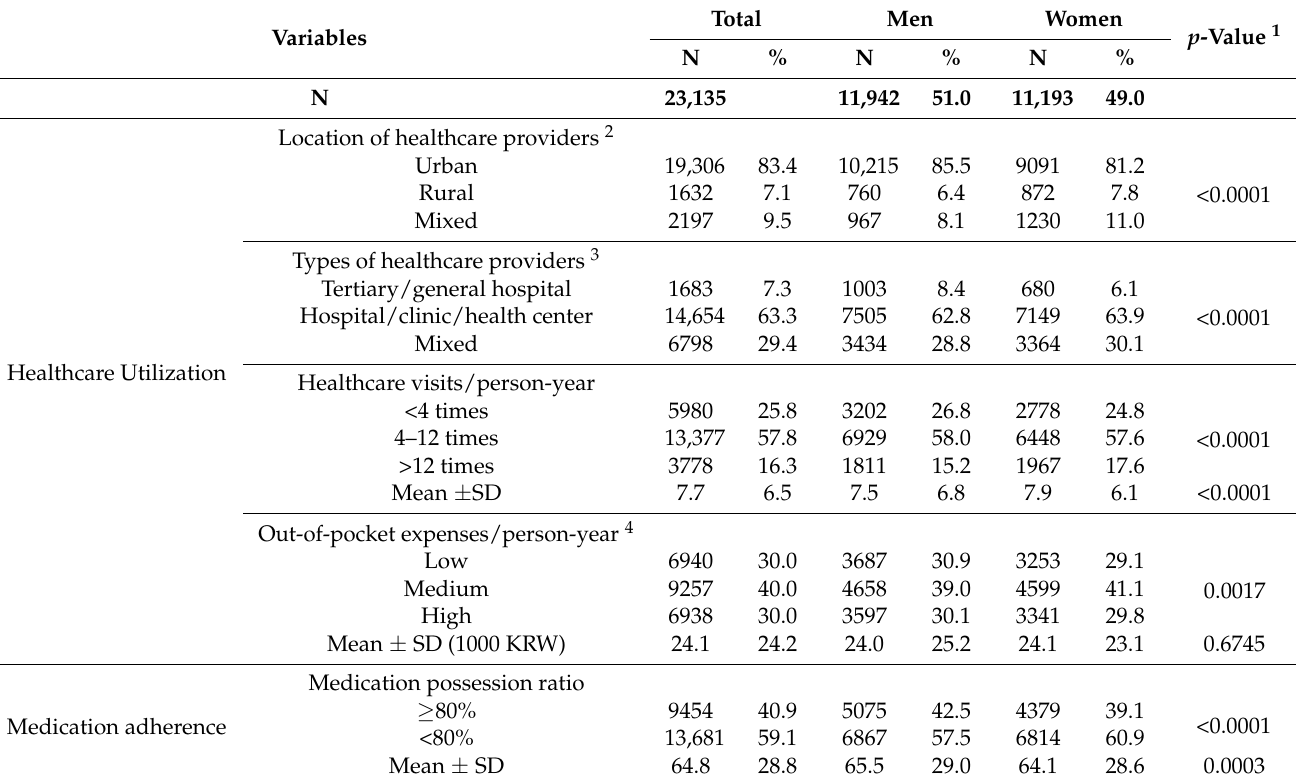
Table 2. Healthcare utilization and medication adherence among hypertensive patients during the study period.